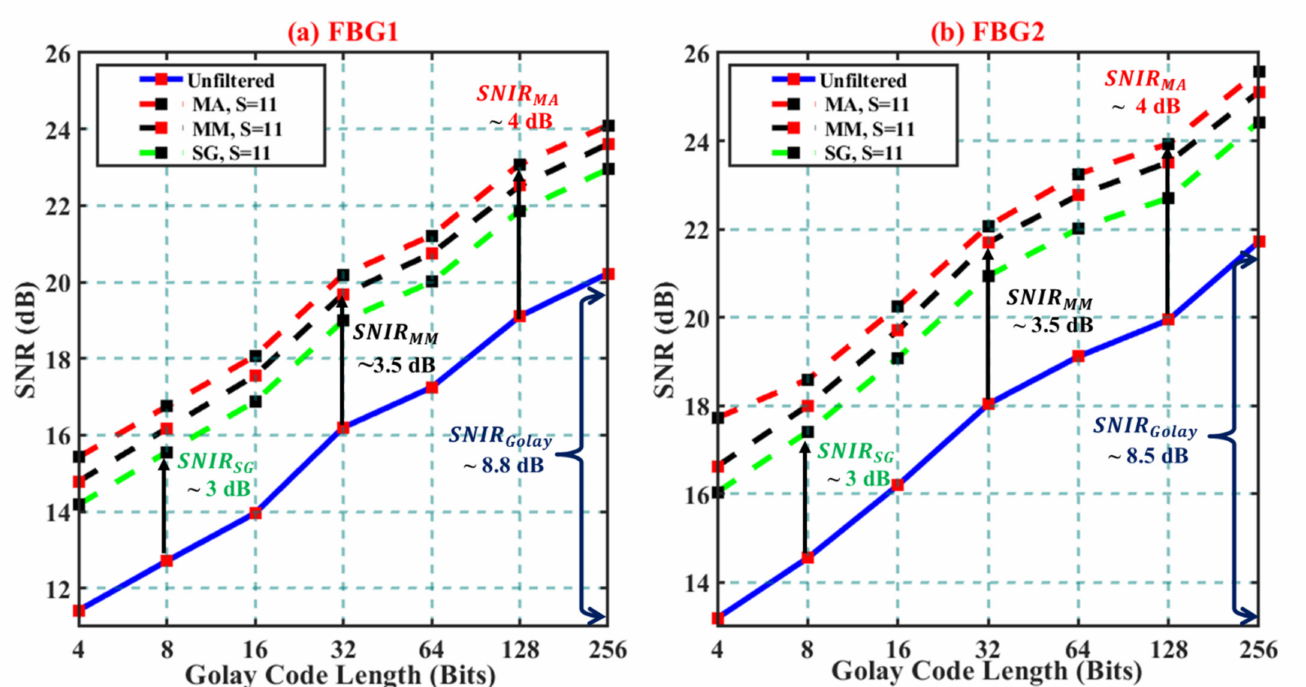
Figure 4. SNR response to increasing Golay codelengths and MA, SG, MM filter when S = 11: ( a ) FBG1; ( b ) FBG